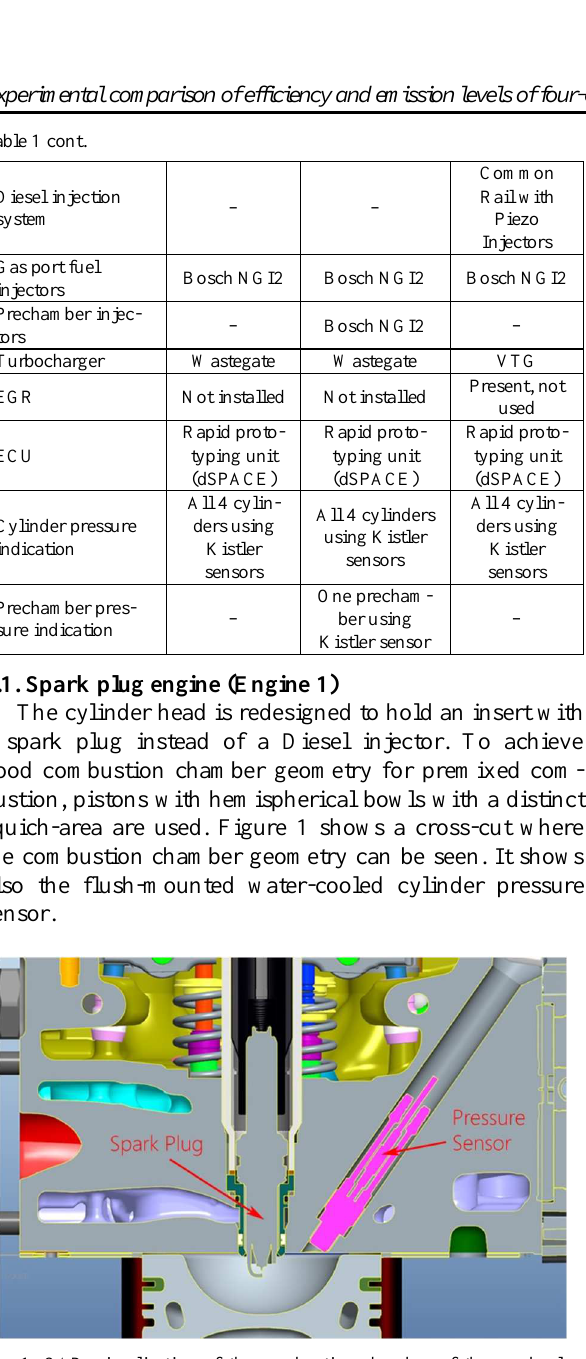
Fig. 1. CAD visualisation of the combustion chamber of the spark plug engine